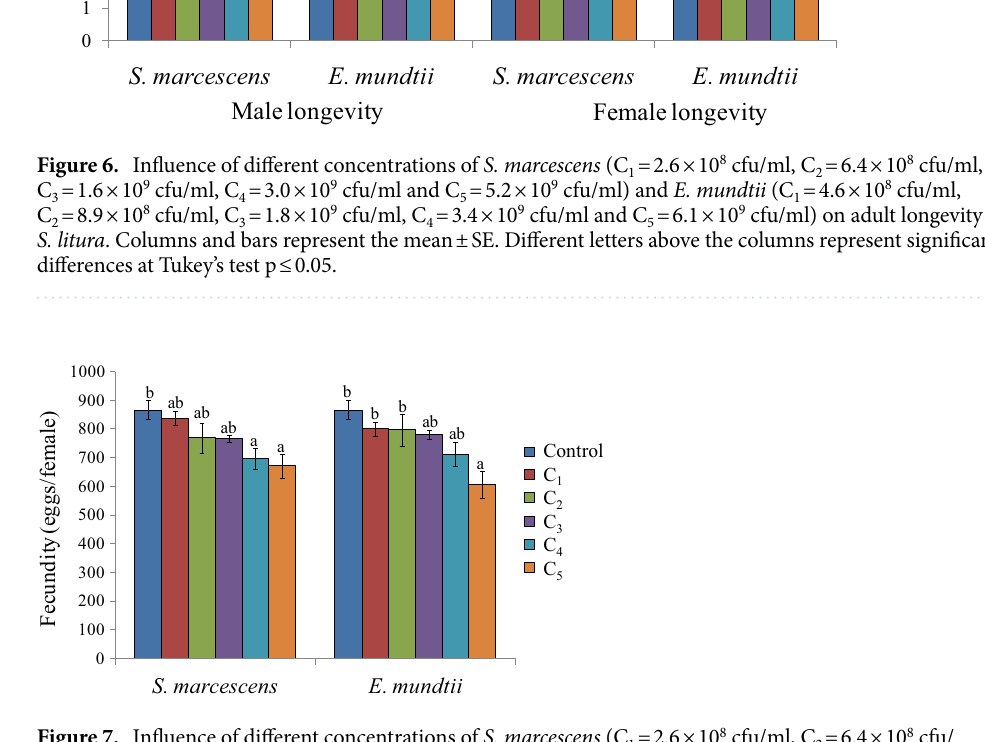
Figure 7. Influence of different concentrations of S. marcescens (C 1 = 2.6 × 10 8 cfu/ml, C 2 = 6.4 × 10 8 cfu/ ml, C 3 = 1.6 × 10 9 cfu/ml, C 4 = 3.0 × 10 9 cfu/ml and C 5 = 5.2 × 10 9 cfu/ml) and E. mundtii (C 1 = 4.6 × 10 8 cfu/ ml, C 2 = 8.9 × 10 8 cfu/ml, C 3 = 1.8 × 10 9 cfu/ml, C 4 = 3.4 × 10 9 cfu/ml and C 5 = 6.1 × 10 9 cfu/ml) on fecundity of S. litura . Columns and bars represent the mean ± SE. Different letters above the columns represent significant differences at Tukey’s test p ≤ 0.05.